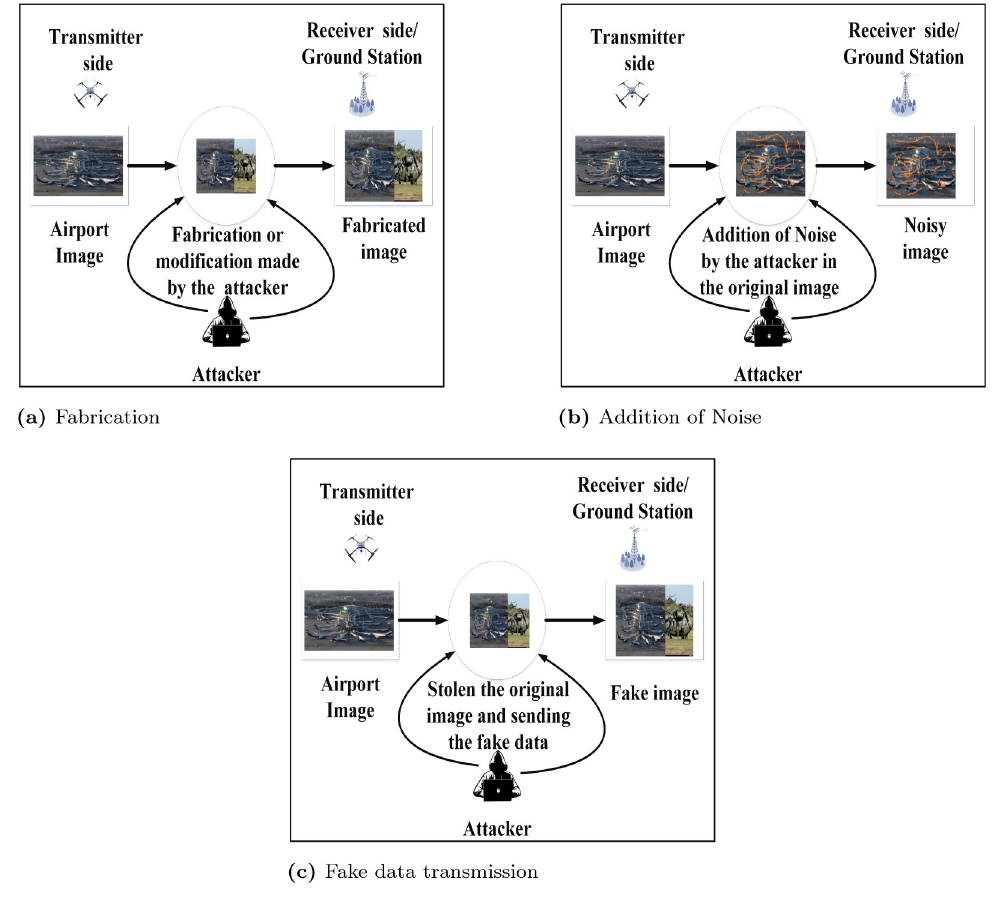
Fig 1. Different categories of attacks. (a) Fabrication, (b) Addition of Noise and (c) Fake data transmission.